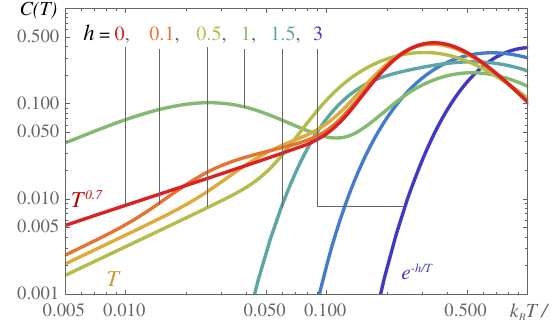
FIG. 7. Specific heat in a magnetic field. Specific heat C ð T Þ is computed within the two-regime model with low-energy singlets, as in Figs. 6(c) and 6(d), here with an application of a magnetic H=J 0 taking the field H with dimensionless energy h ≡ g μ B values h ¼ 0 , 0.1, 0.2, 0.5, 1, 1.5, 2, 3 (red to violet colors). The anomalous curve at h ¼ 1 is due to a resonance with the narrow distribution chosen for Fig. 6(a). Applying a small field changes the low-temperature scaling of specific heat from C ð T Þ ∼ T 0 . 7 to a linear form ∼ T=H 0 . 3 , then turning to an exponential form at larger fields. (For modifications of the scaling by spin-orbit coupling, see also Ref.